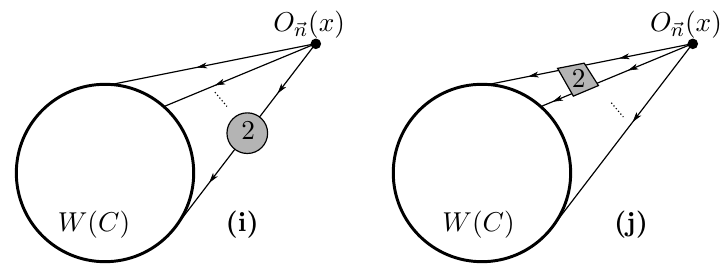
Figure 7 . Diagrams that contribute to (cid:14)A ~n at two loops in the N = 2 superconformal theory. Dia- gram ( i ) on the left contains the irreducible two-loop correction of the scalar propagator represented in (cid:12)gure 8, while diagram ( j ) on the right contains the two-loop e(cid:11)ective vertex depicted in (cid:12)gure